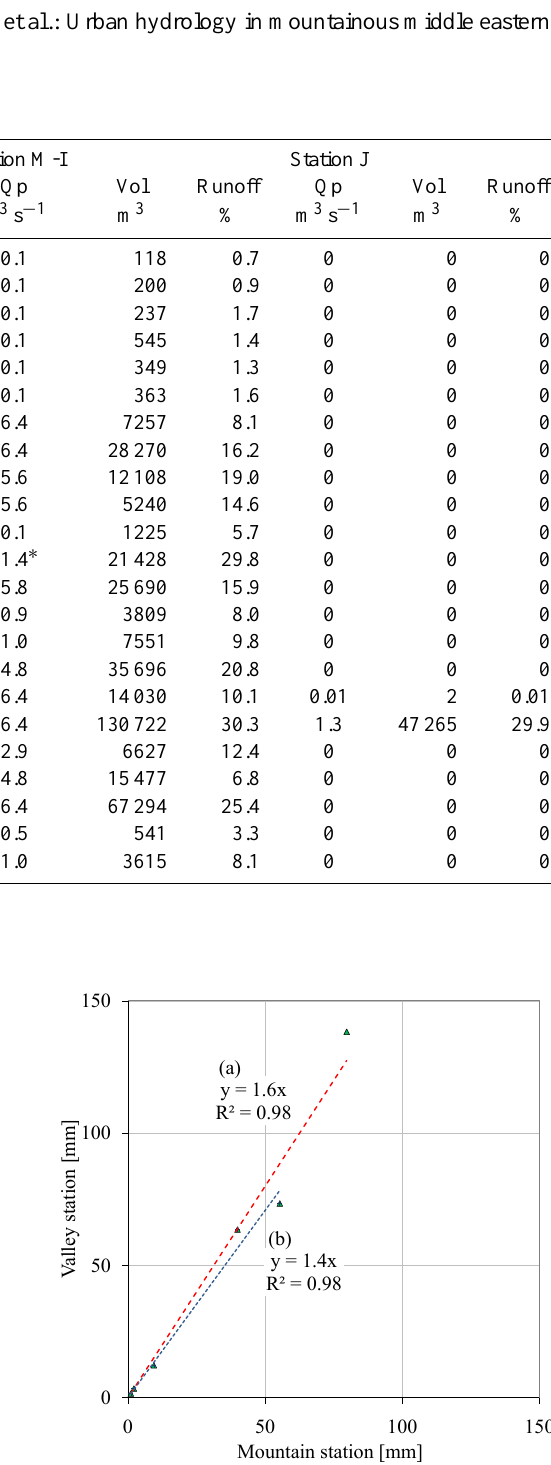
Fig. 5. Ramallah: valley station plotted against ridge station: (a) with all measured substorms rainfall data and (b) excluding the extreme